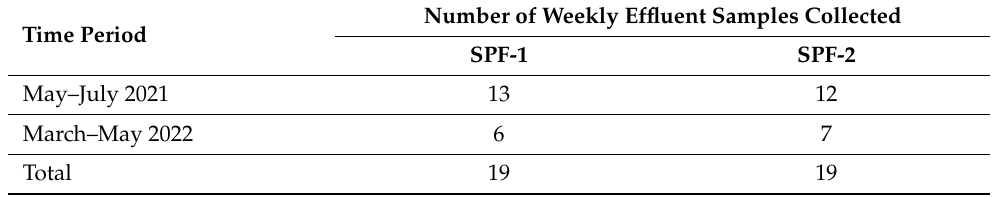
Table 1. Number of weekly effluent samples collected from the two seafood processing facilities (SPF) in Tema, Ghana during 2021 and